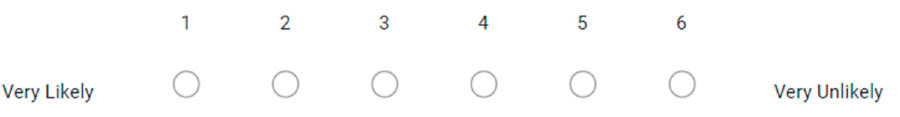
Figure 3. Likert Scale that was implemented for uncertainty and unwillingness to vaccinate against COVID-19 .